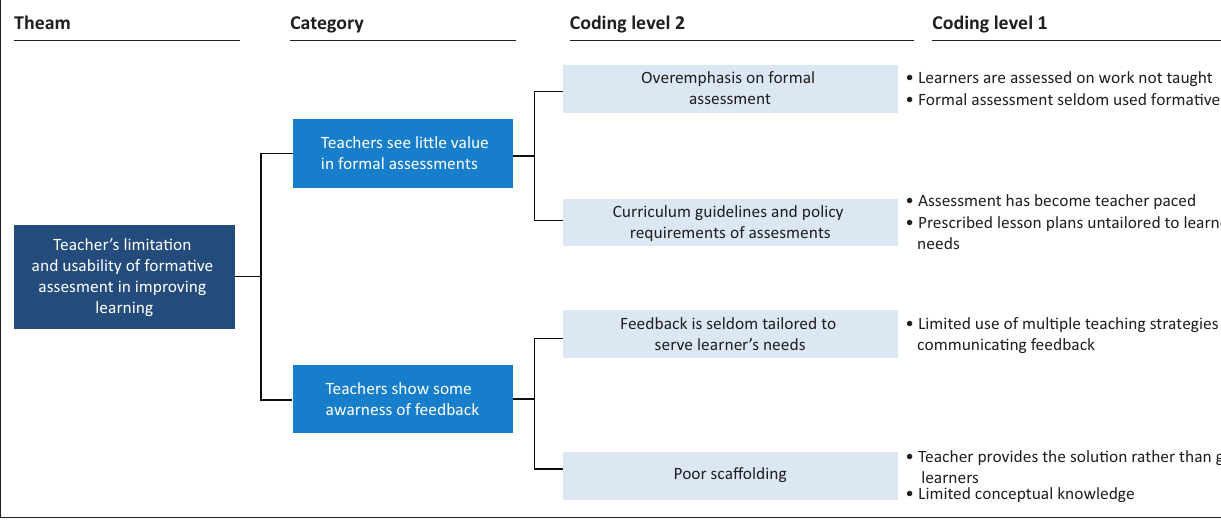
FIGURE 1: An example of a flowchart from one theme backwards to